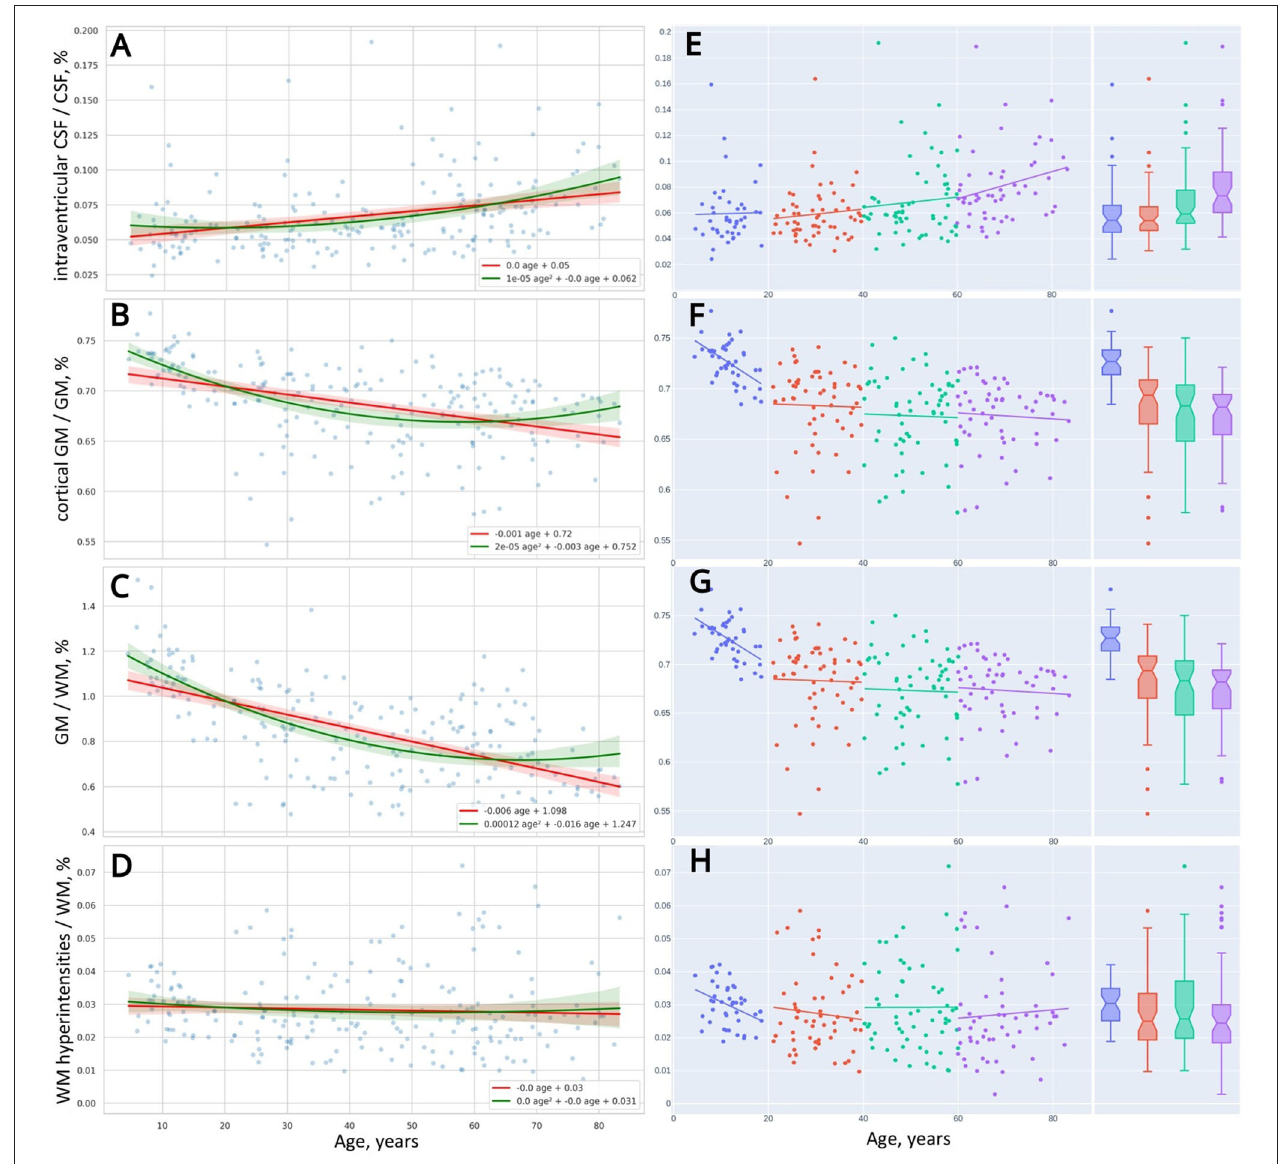
FIGURE 4 | Distribution of brain morphometric indices over age (A–D) . Linear trendlines of changes in the indices across four life periods (E–H)